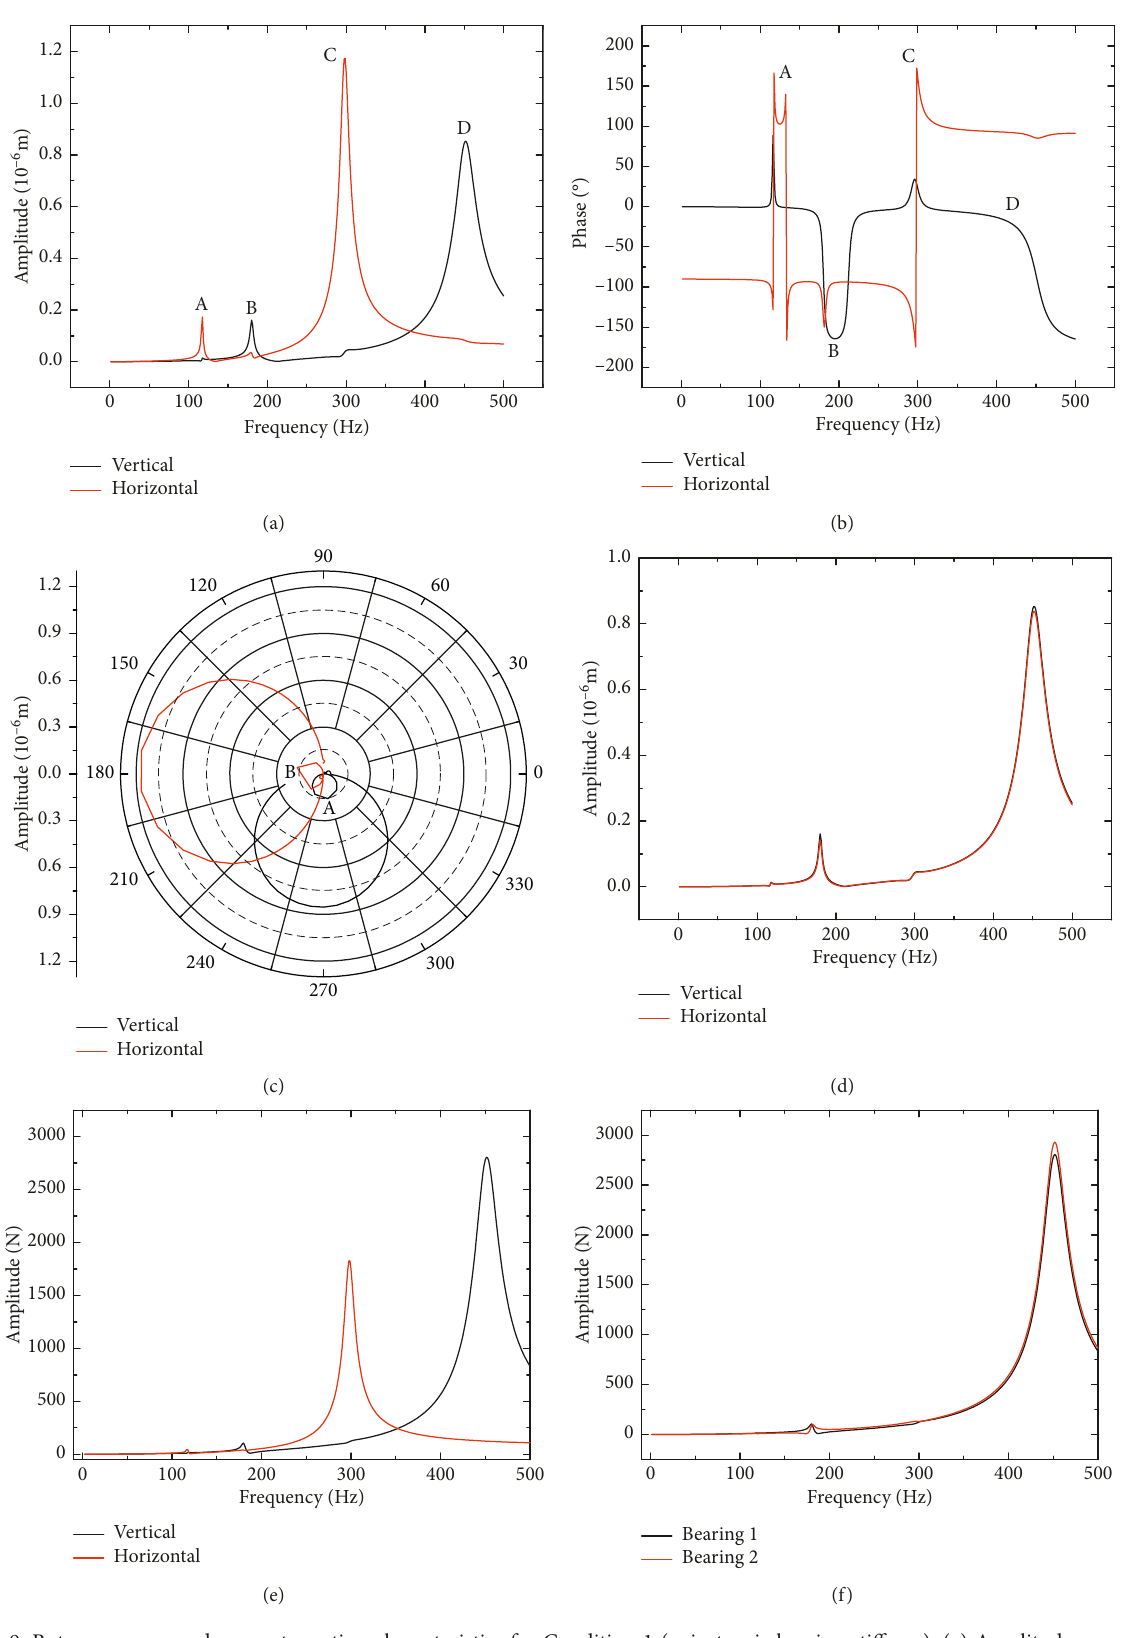
Figure 9: Rotor response and support reaction characteristics for Condition 1 (anisotropic bearing stiffness). (a) Amplitude response at node 0. (b) Phase response at node 0. (c) Polar diagram at node 0. (d) Amplitude response at vertical direction. (e) Support reaction of bearing 1. (f) Support reaction at vertical